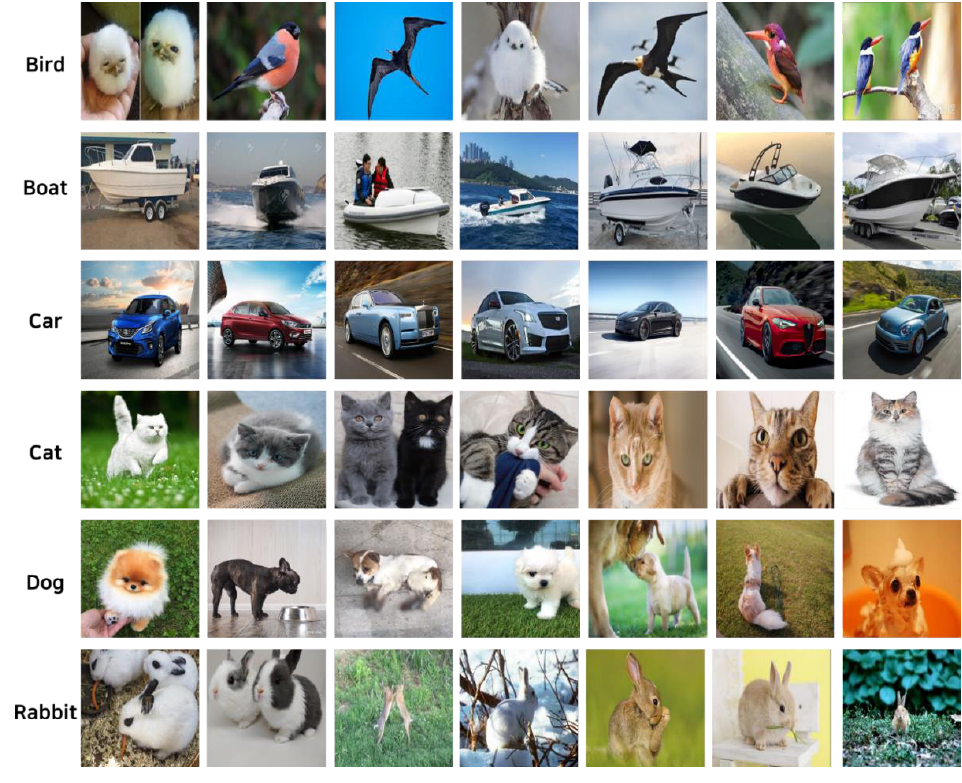
Figure 6. Caltech 101 data set. Table 4. Configuration of crawling data set.